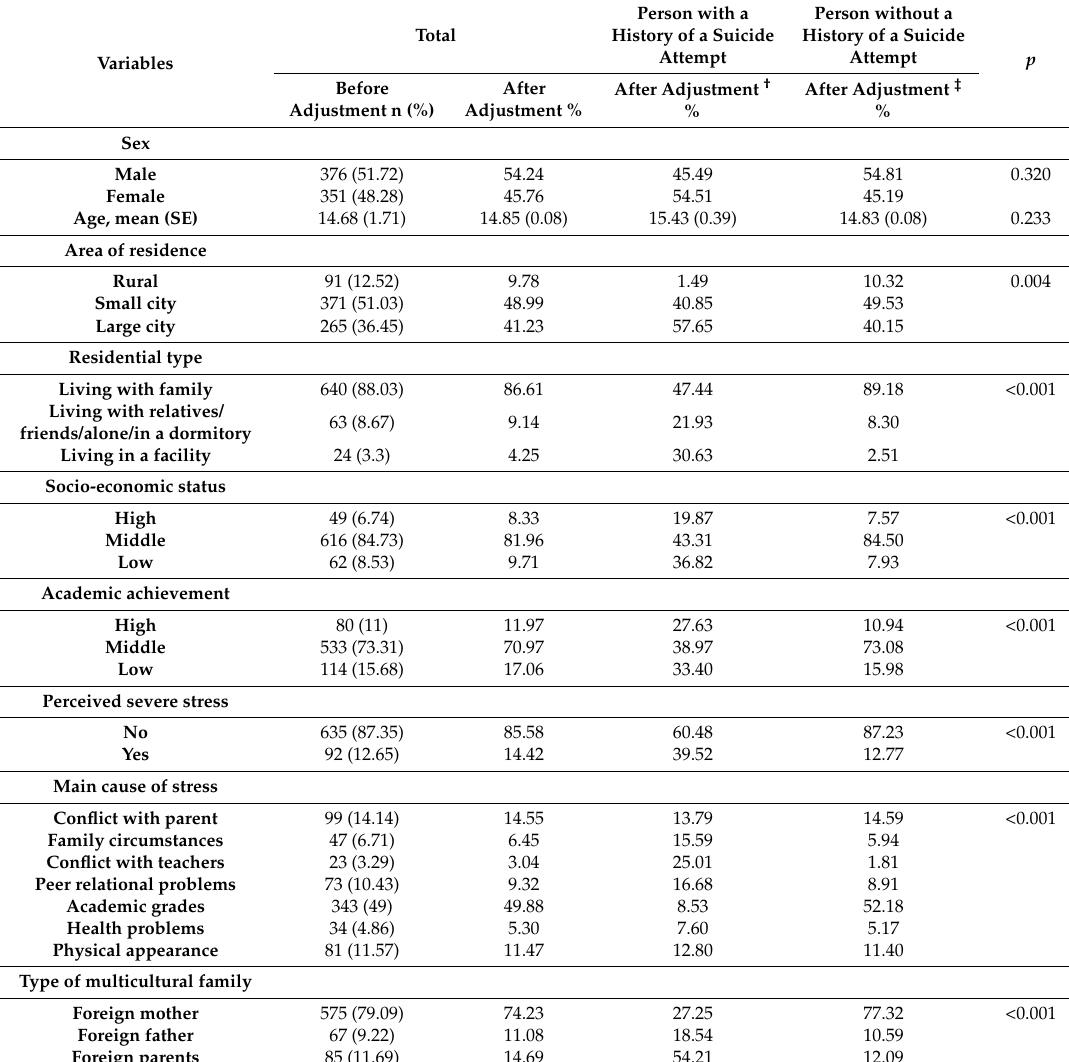
Table 2. Characteristics of the study population ( n =